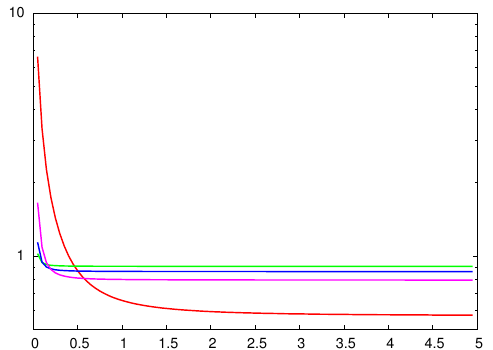
Fig. 15. Evolution of the ratio output noise/input noise depend- ing on the value of input noise for decorrelated noise ( β = 0). Red curve: fusion; green curve: median filter with 3 × 3 neighbourhoods; blue curve: median filter with 5 × 5 neighbourhoods; purple curve: median filter with 11 × 11 neighbourhoods. For large input noises fusion performs better than the others; the crossover points occur for input noise levels of about 0.75, 1.25, and 3.25, respectively.